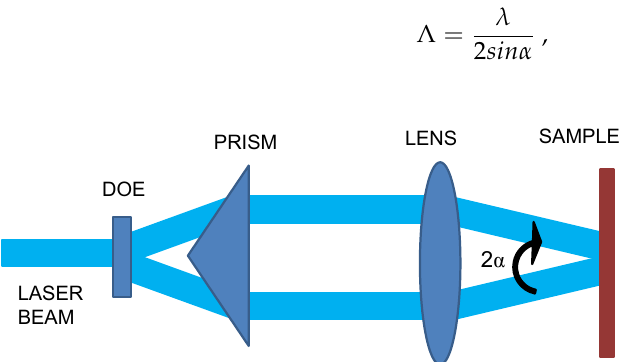
Figure 1. Schematic representation of direct laser interference patterning (DLIP) setup.